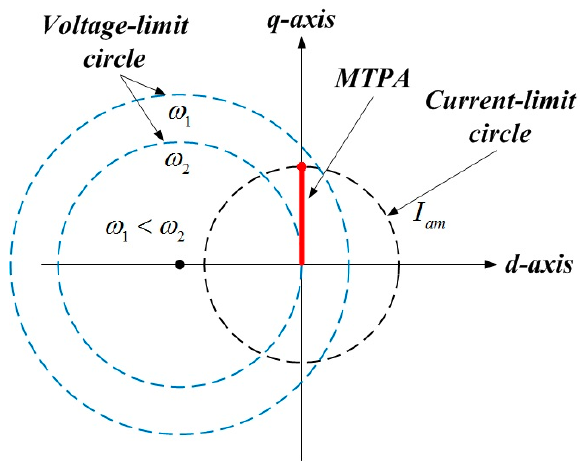
Figure 2. MTPA curve of SPMSM.